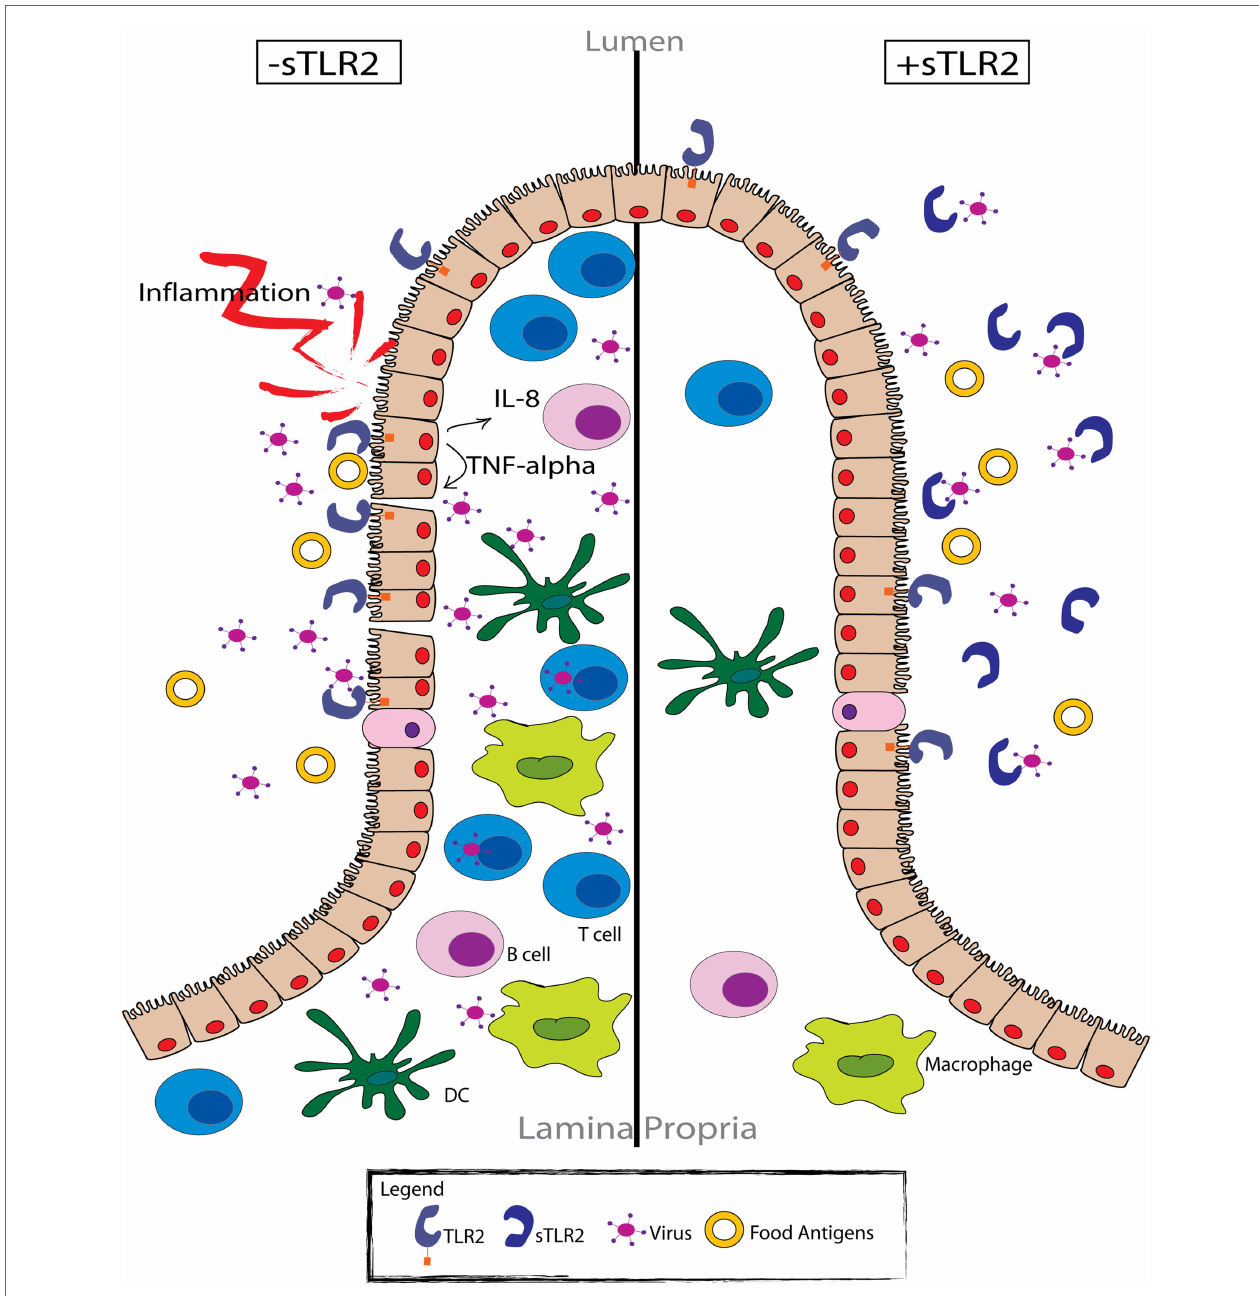
FiGURe 2 | sTLR2 functions as an immunoregulatory factor in the intestinal mucosa . Pathogen exposure (e.g., HIV) results in TLR activation of the intestinal epithelial cells (left). Cellular activation promotes the production of various pro-inflammatory cytokines and chemokines, as well as the subsequent recruitment of effector cells to the site of exposure. However, many of these cells (i.e., CD4 + T cells and monocyte/macrophages) are viral target cells, providing an abundant number of host cells for the virus to infect. Therefore, activation of the immune response serves to propagate the viral infection, as well as the local inflammatory response. Conversely, in the presence of sTLR2 (right), viral proteins that typically activate various TLRs expressed by intestinal epithelial cells are sequestered, preventing the activation of the immune response. In this respect, sTLR2 functions as a regulatory molecule, limiting the available target cells for viral infection and the local inflammatory